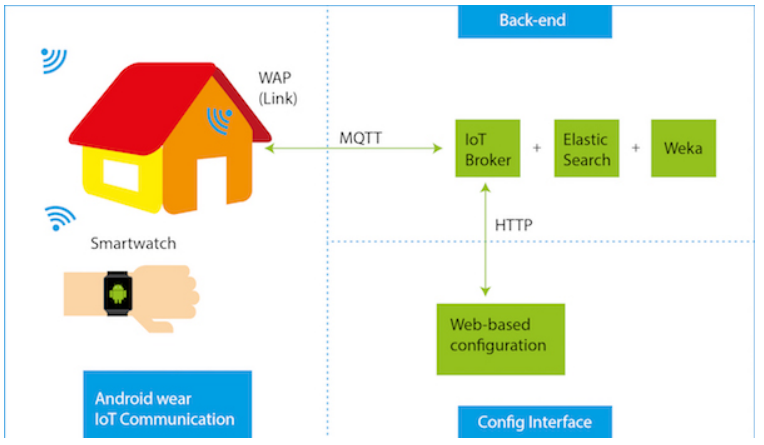
Figure 2. The three parts of the proposed